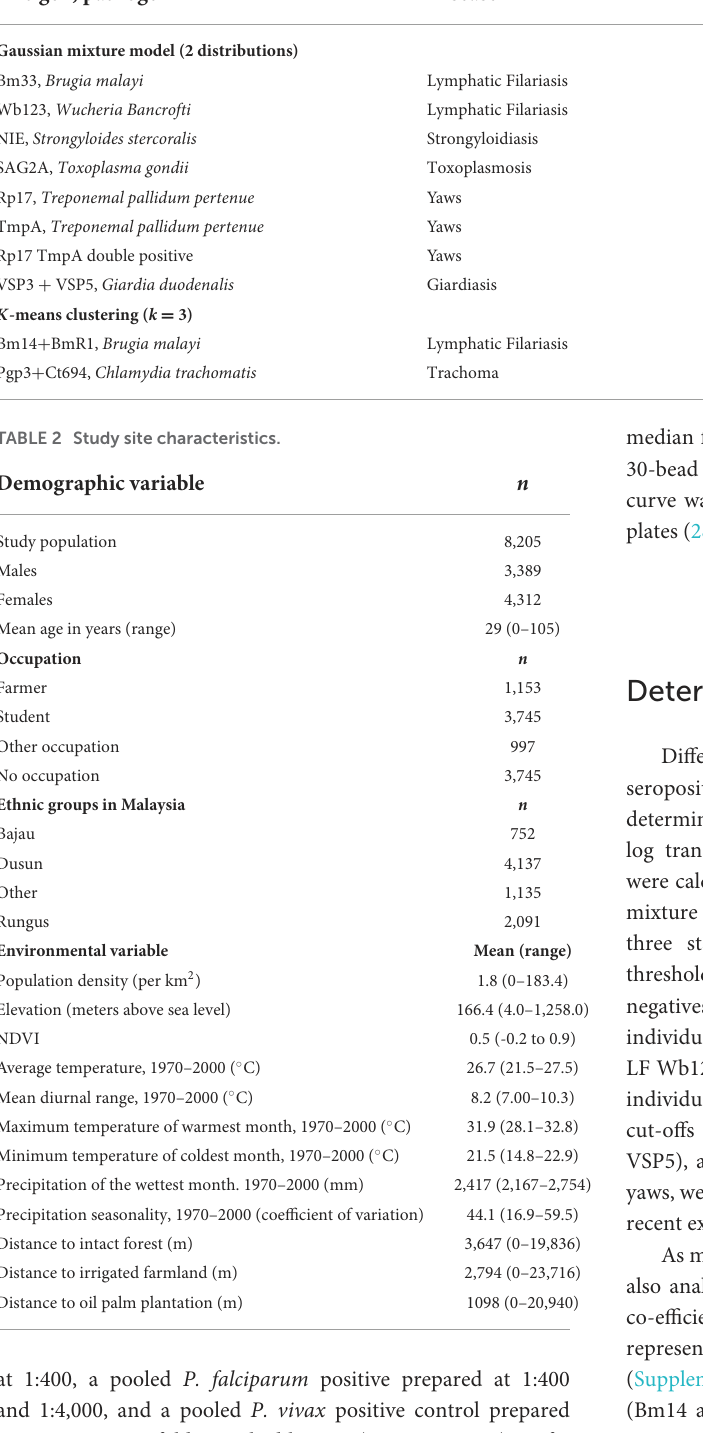
TABLE 1 Cut-off method, seroprevalence and vaccine exposure in percentages, and number of individuals per antigen. Antigen, pathogen